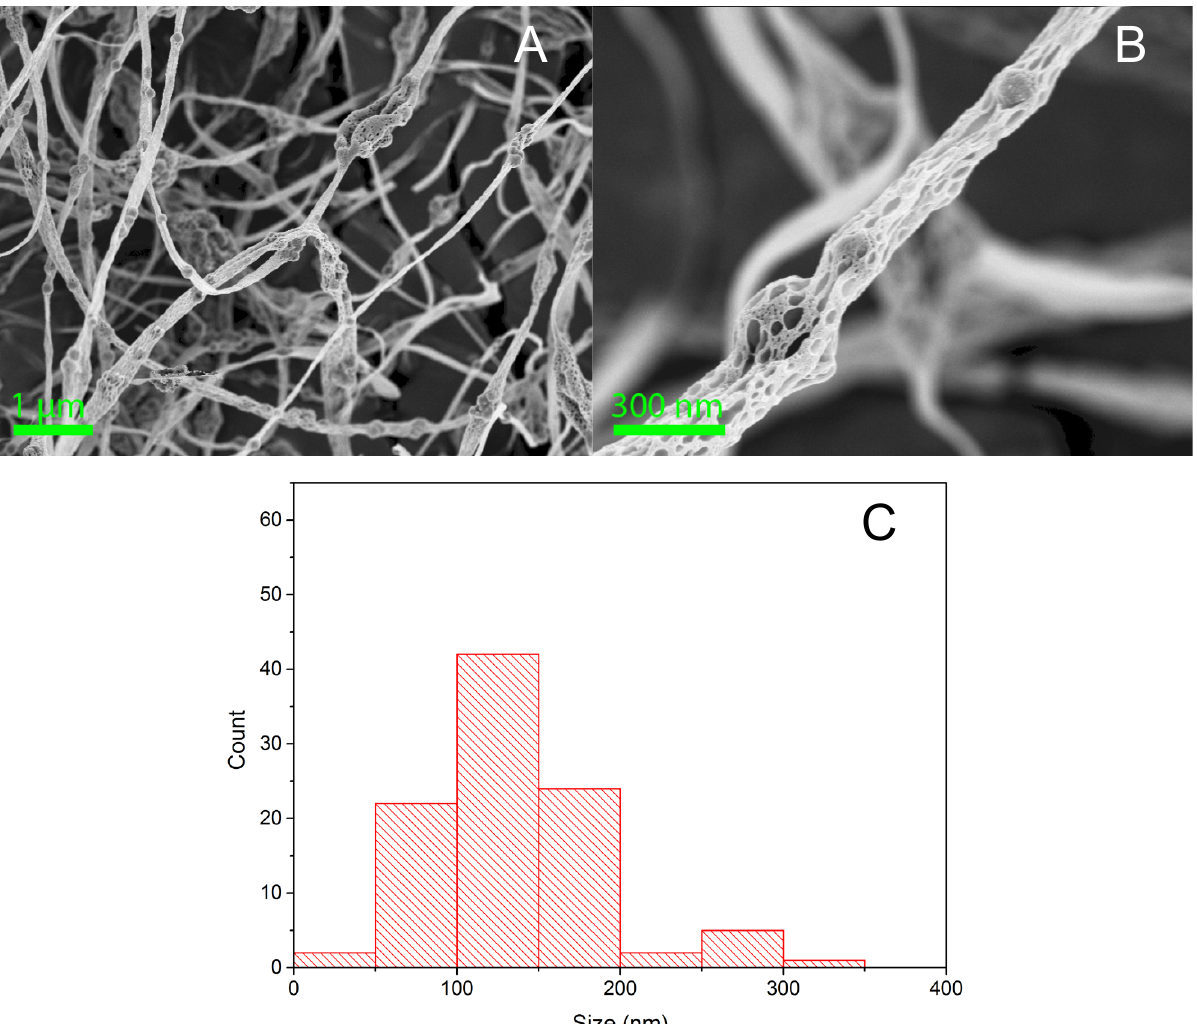
Figure 5. SEM image of Electrospun 10% by weight CA/LTA porous fibers ( A ) and at higher magnification ( B ) with the measured fiber diameter distribution shown in the histogram ( C